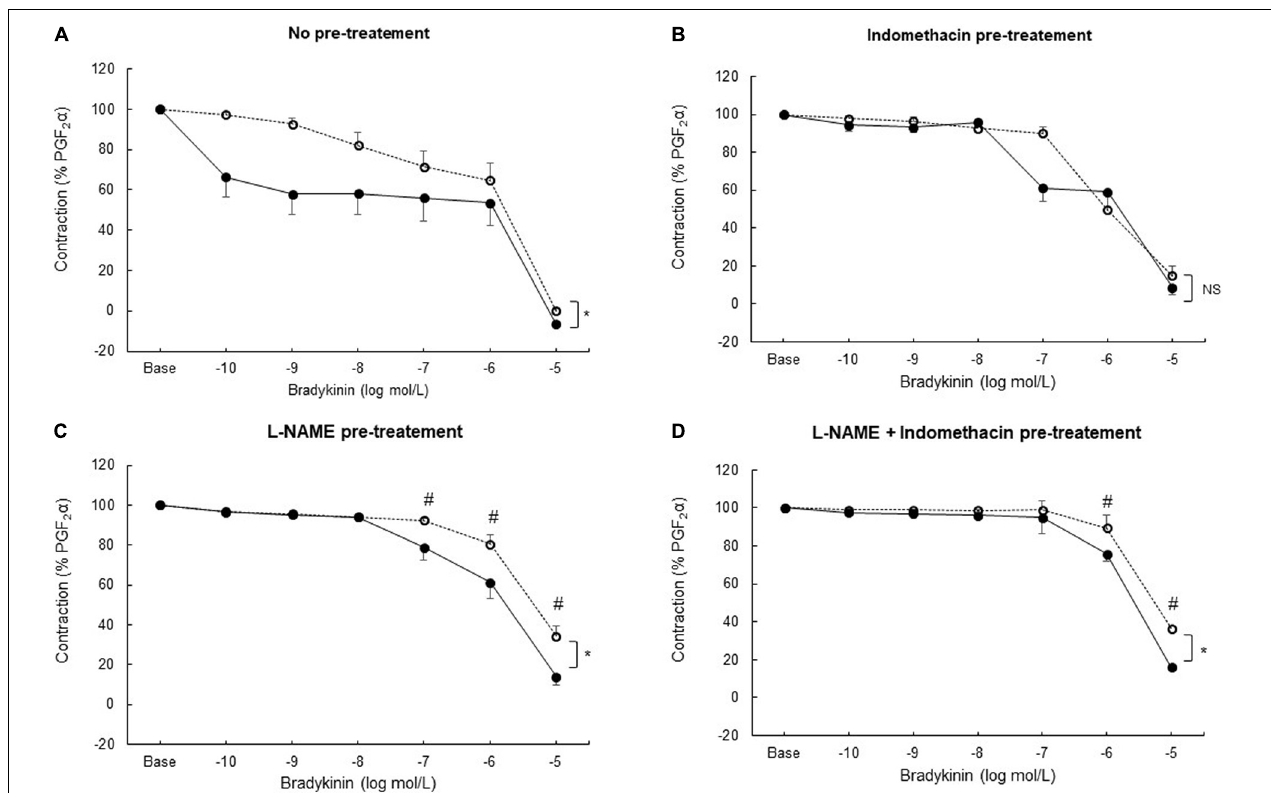
FIGURE 3 | Ex vivo coronary vasomotor response. Relaxing concentration–response curves to bradykinin (tested from 10 − 10 to 10 − 5 mol/L) after prostaglandin F 2 α (PGF 2 α ; 10 − 5 mol/L) precontraction in coronary arteries rings from sham (open circles; n = 25–27 coronary rings from seven pigs) and sepsis groups (solid circles; n = 21–24 rings from seven pigs) in the absence of pre-treatment (A) and after pre-treatment with a cyclooxygenase inhibitor (indomethacin;10 − 5 mol/L) (B) ; with a nitric oxide synthase inhibitor (L-NAME; 2.5. 10 − 4 mol/L) (C) ; with both indomethacin (10 − 5 mol/L) and L-NAME (2.5. 10 − 4 mol/L) pre-treatment (D) . Relaxation response was expressed as the percentage of the maximal contraction response to PGF 2 α . Results are presented as mean ± SEM. * p < 0.05 sepsis vs. sham groups (global curve analysis); # p < 0.05 sepsis vs. sham groups (point-by-point analysis). NS: not significant.